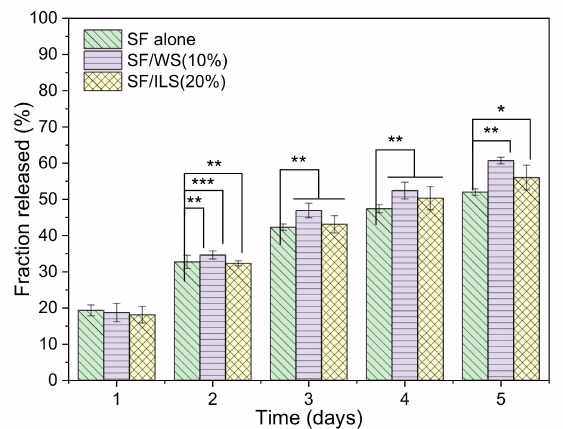
Figure 11. Histogram of bovine insulin release of pure SF and SP composite scaffolds. G-SF, SF/WS (10%), SF/ILS (20%) represent the graft SF scaffold and the incorporation of 10% G-WS and 20% G-ILS, respectively; n = 3. * Represents p < 0.05, vs. SF alone; ** Represents p < 0.01, vs. SF alone; *** representing p < 0.001, vs. SF